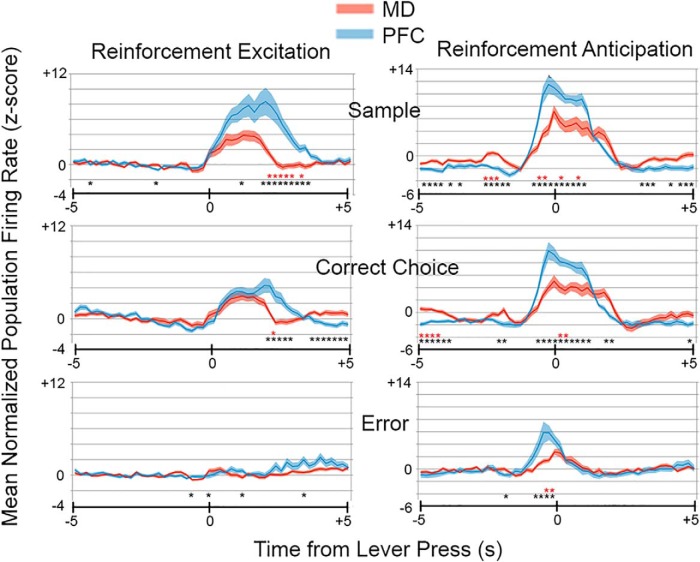
Normalized population responses for reinforcement excitation and anticipation responses in MD and PFC. Results are plotted from 5 s before until 5 s after sample, correct choice, and incorrect choice lever presses in 200-ms time bins. Results show average activity of 47 neurons in MD and 38 in mPFC for reinforcement excitation and 28 neurons in MD and 22 in mPFC for reinforcement anticipation. Black asterisks indicate time bins that differed at p < 0.05, and red asterisks, bins that differed at p < 0.001 (Bonferroni correction for α = 0.05) for two-tailed Mann–Whitney tests. Thin dark lines represent the mean; wider light colored lines the SEM.